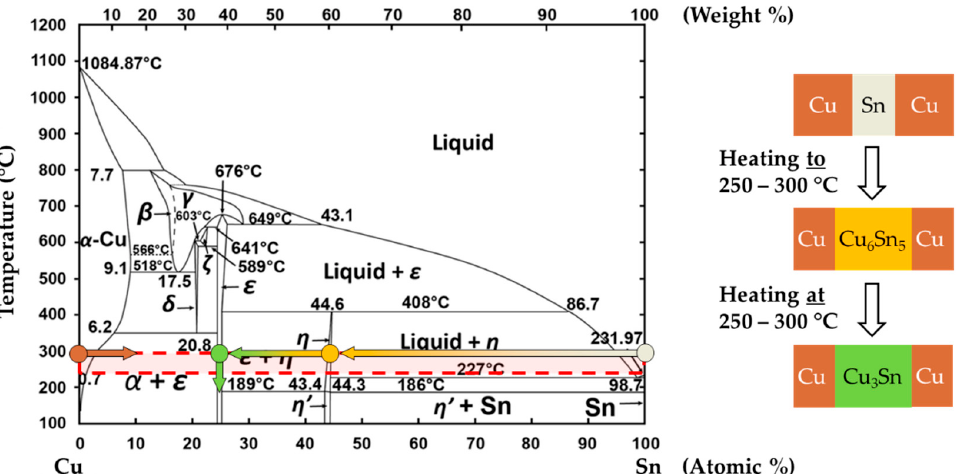
Figure 2. Representation of the Cu-Sn phase diagram with the IMC formation, where the red dot and gray dot are related to the original copper and tin layers, respectively. The yellow dot shows the first formed η -phase Cu 6 Sn 5 , the green dot the stable ε -phase Cu 3 Sn. Reprinted/adapted with permission from Ref. [48]. Copyright 2017, copyright Charlie Sanabria.